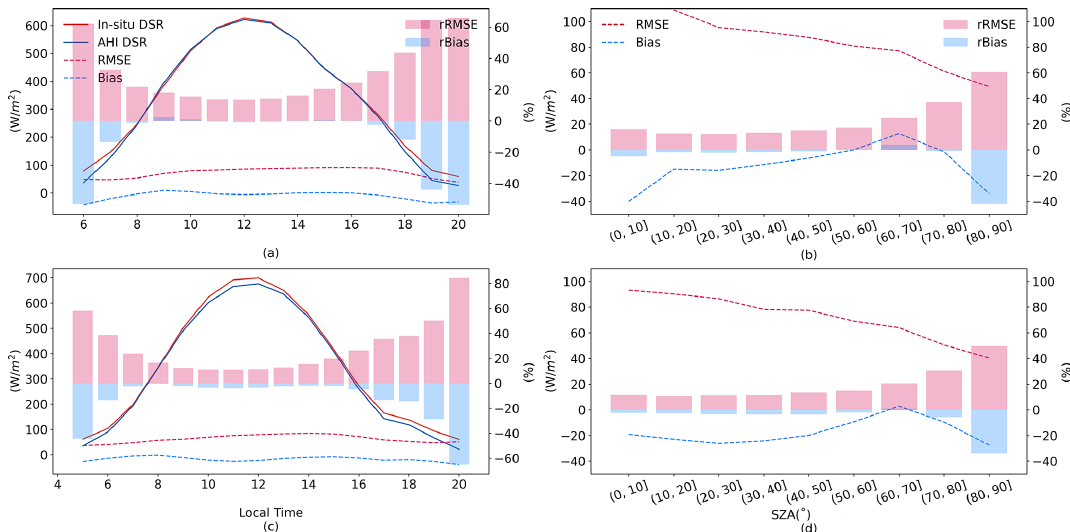
Figure 8. Diurnal variation of DSR estimation for ABI (a) and AHI (c) and the impact of SZA on ABI (b) and AHI (d) estimation. The left-hand y axis corresponds to the line plot, while the right-hand y axis corresponds to the bar plot.